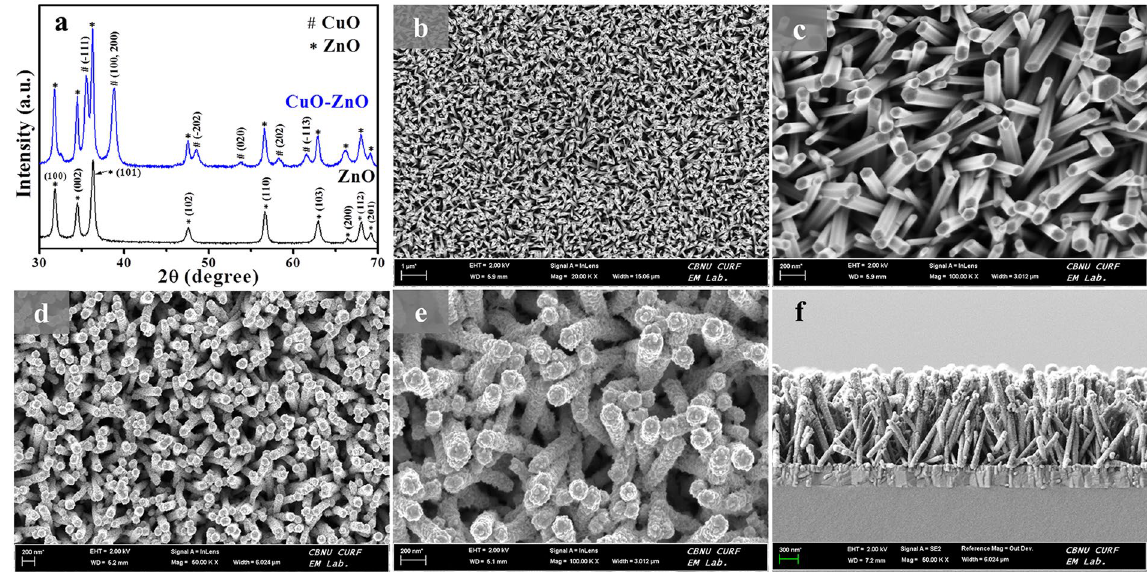
Figure 2. ( a ) XRD patterns of as-synthesized ZnO NRs and CuO modified ZnO NRs. ( b ) Low- and ( c ) high- resolution FESEM images of as-grown ZnO NRs. ( d ) Low-, ( e ) high-resolution, and ( f ) cross sectional FESEM view of CuO modified ZnO